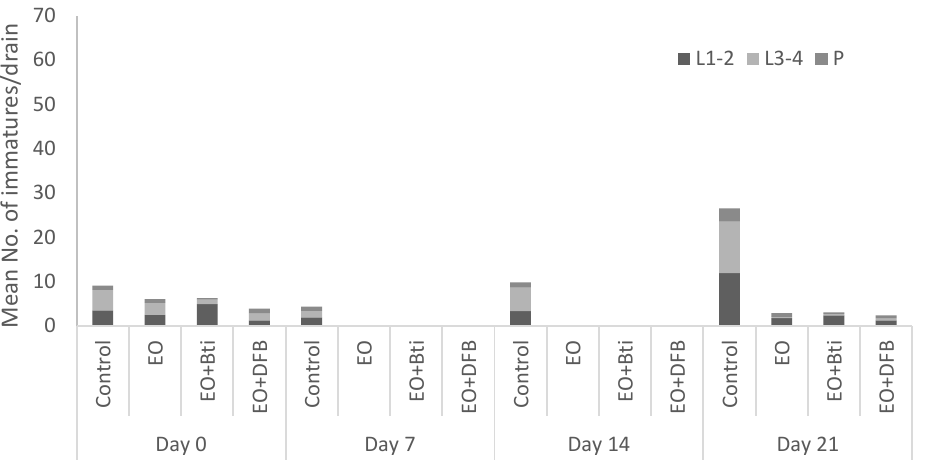
Figure 2. Immature mosquito population (1st–2nd and 3rd–4th instar larvae and pupae) of Ae. albopictus pre-treatment (Day 0) and post-treatment (Days 7, 14, and 21) with oregano essential oil (EO), oregano essential oil + diflubenzuron (EO+DFB), and oregano essential oil + B.t.i. (EO+ B.t.i. ) in road drains in Crevalcore, Italy, during July 2019.